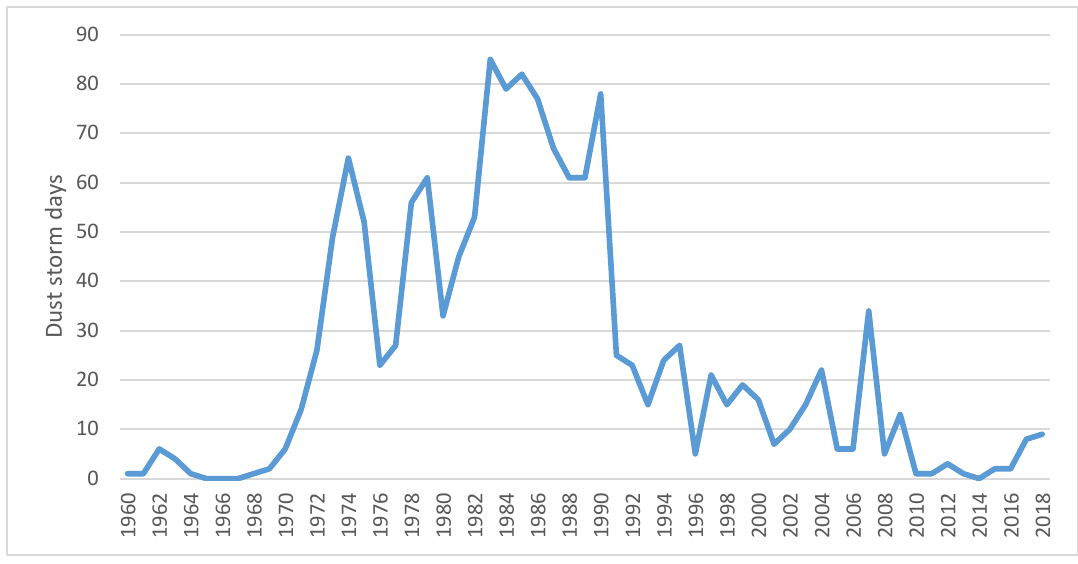
Figure 1. Annual frequency of dust storm days 1960 – 2018 at Nouakchott (18.12° N 15.95° W). (Data source: Office National de la Météorologie, Mauritania).